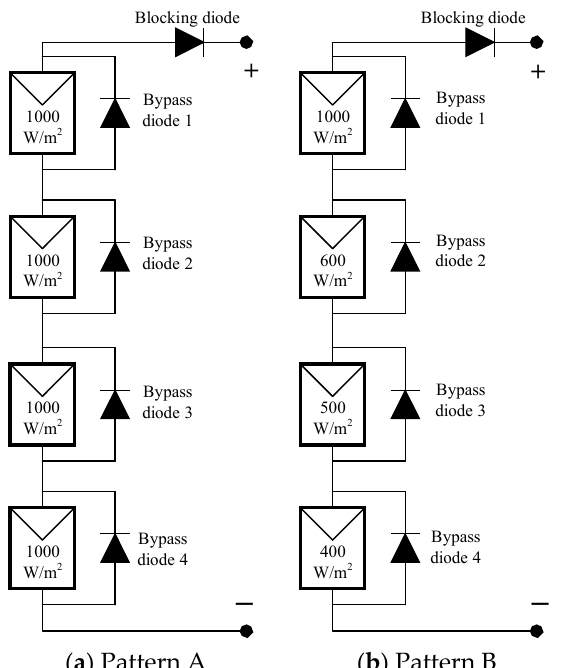
Figure 3. Operation of a PV array under ( a ) uniform irradiance and ( b ) partial shading conditions (PSCs).